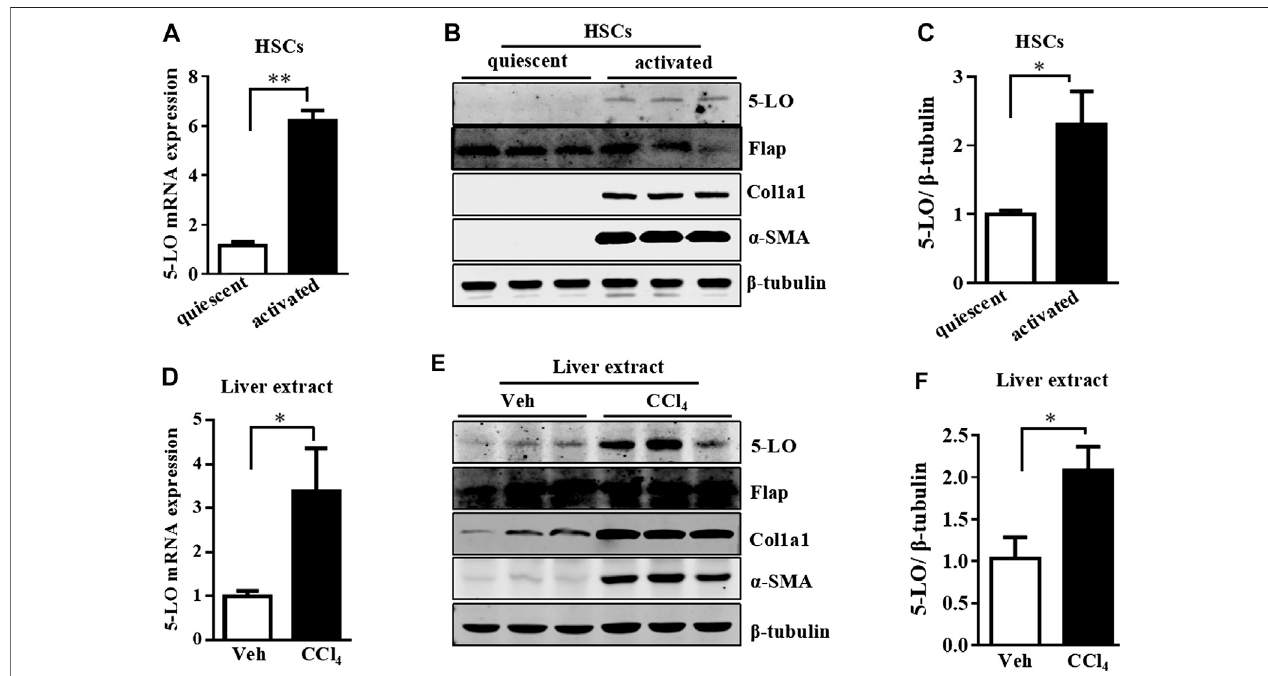
FIGURE3| 5-LOwasupregulatedina-HSCand fi broticlivers.ThemRNAandproteinlevelsof5-LOdetectedinq-HSCanda-HSC (A – C) andwithCCI 4 treatment in mouse livers (D – F) . The protein levels of Flap, Col1a1, α -SMA and β -tubulin were also detected in all above groups (B,E) .